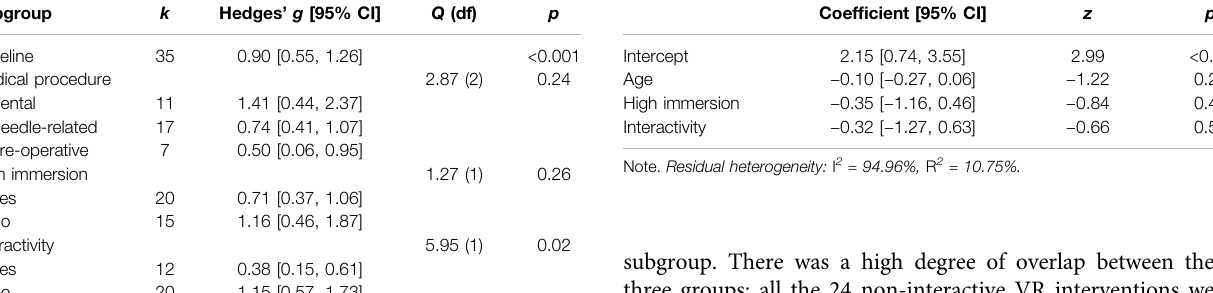
TABLE 6 | Subgroup analyses of the effects of VR on anxiety. Subgroup